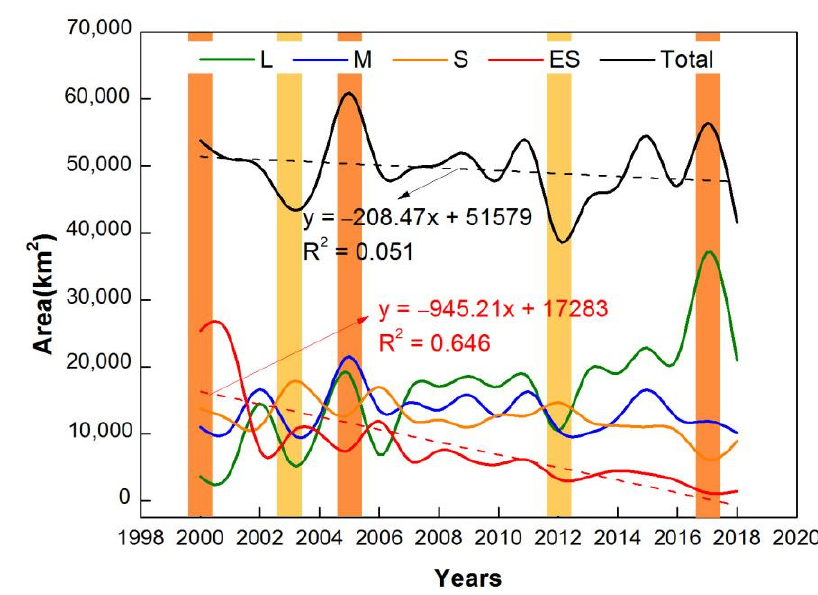
Figure 7. The temporal trends of different levels of desertification in Mu Us Sandy Land from 2000 to 2018. L—light desertification, M—moderate desertification, S—severe desertification, ES—extremely severe desertification, Total—total desertification. 2000, 2005 and 2017 are classified as relatively arid years (orange histogram); 2003 and 2012 are classified as relatively humid years (yellow histogram).